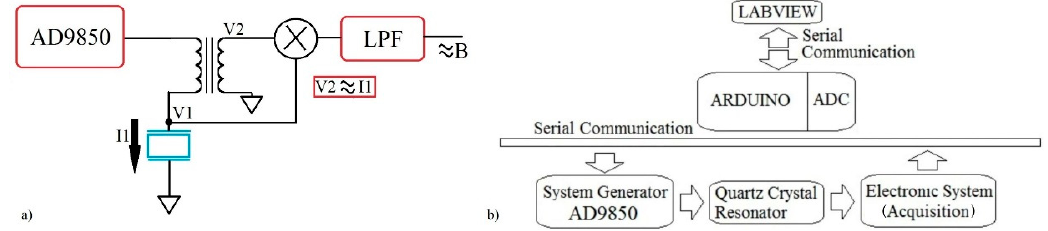
Figure 4. ( a ) Simplified Diagram Acquisition System of the Biosensor; ( b ) Blocks Diagram System of the Biosensor.